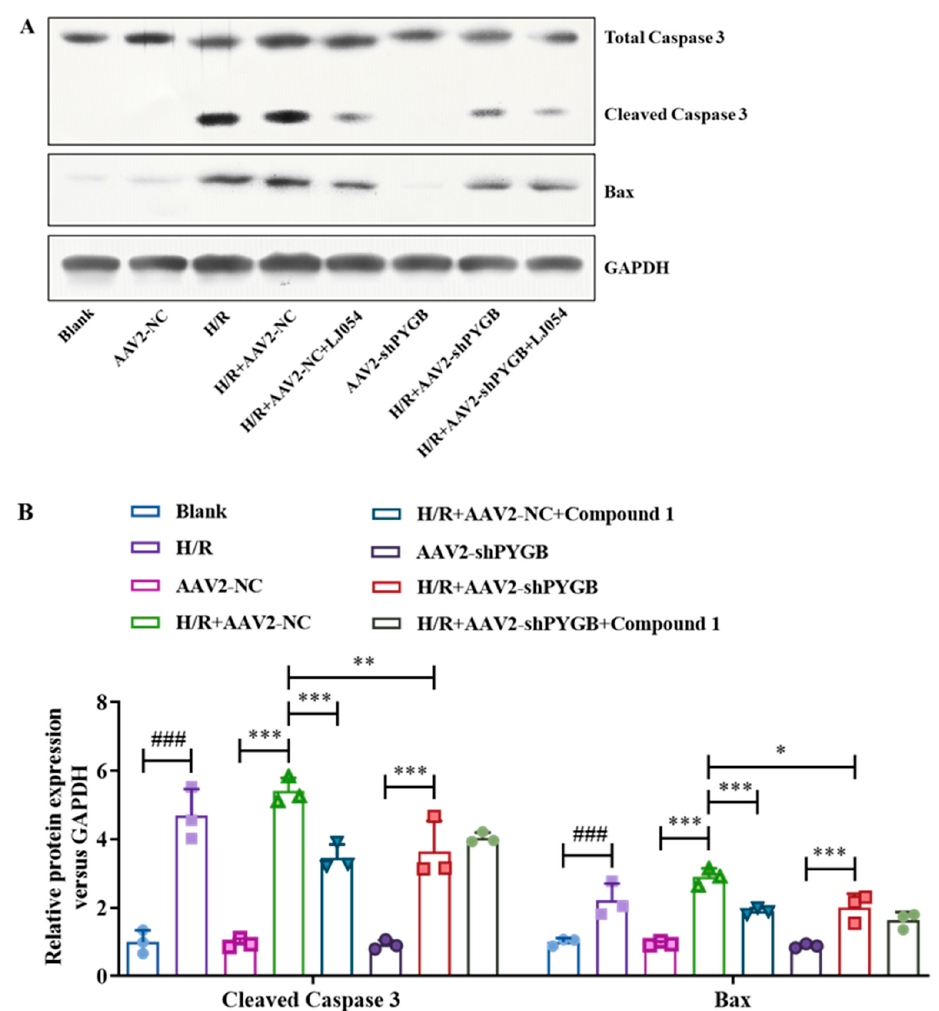
Figure 7. ( A ) Western blot image of total caspase-3, cleaved caspase-3, Bax, GAPDH protein. ( B ) Bax and cleaved caspase-3 protein expression. Protein content was normalized to GAPDH. Data represent mean ± SD (* p < 0.05, ** p < 0.01, *** p < 0.001; ### p <